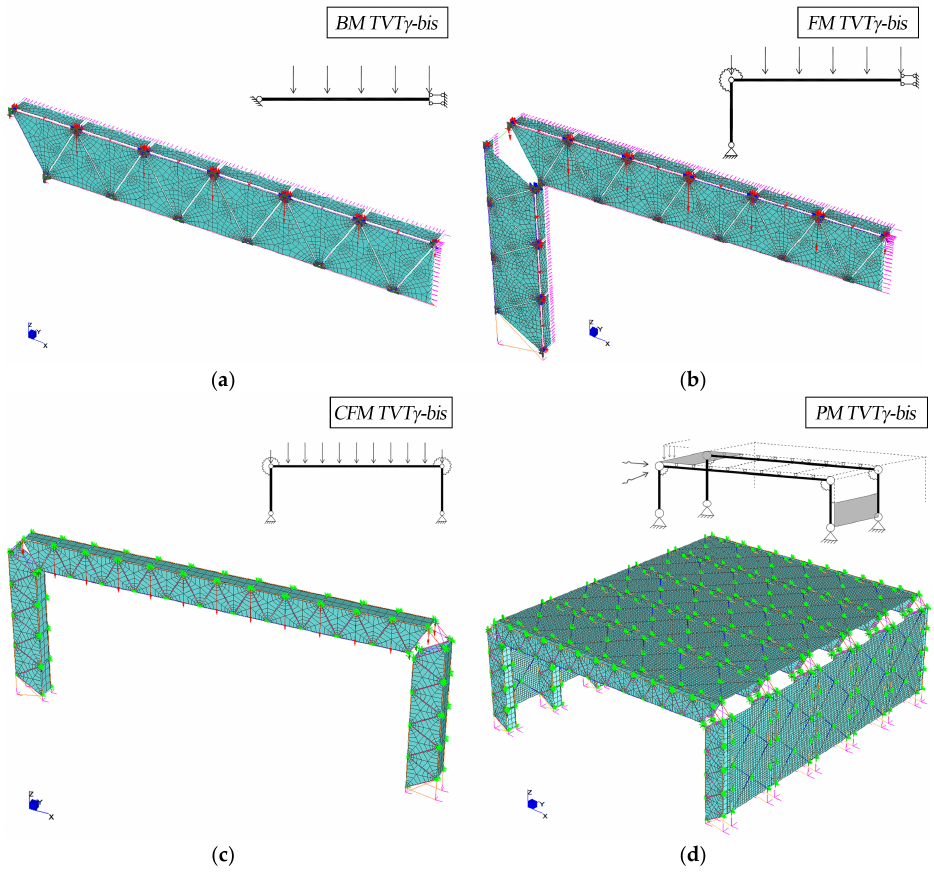
Figure 10. FE models: ( a ) BM TVT γ‐ bis; ( b ) FM TVT γ‐ bis; ( c ) CFM TVT γ‐ bis; ( d ) PM TVT γ‐ bis